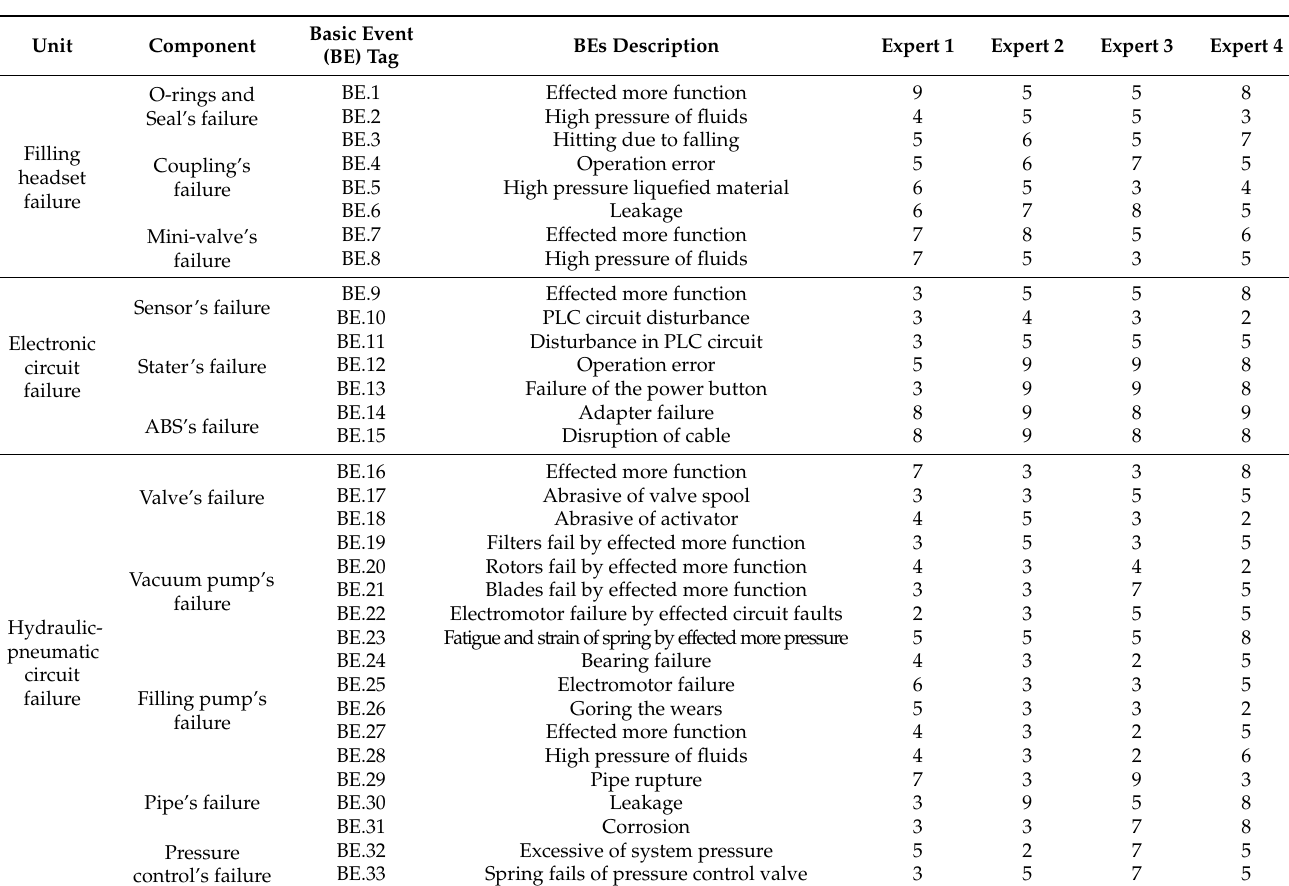
Table 6. The details of the basic events under experts’